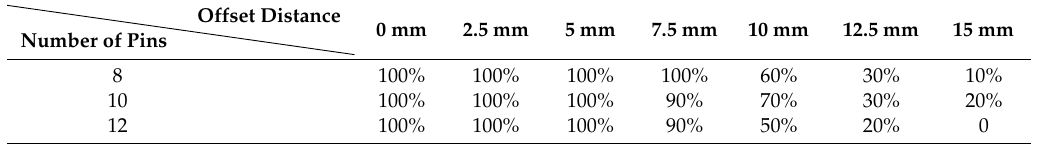
Table 6. The effect of the offset distance of the object on the grasping